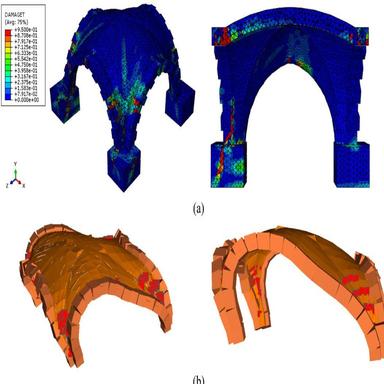
Unreinforced vault. (a) Tensile damage contour plot at failure for FE-CDP model. (b) Deformed shape at collapse and indication of cracked interfaces for RBS model.